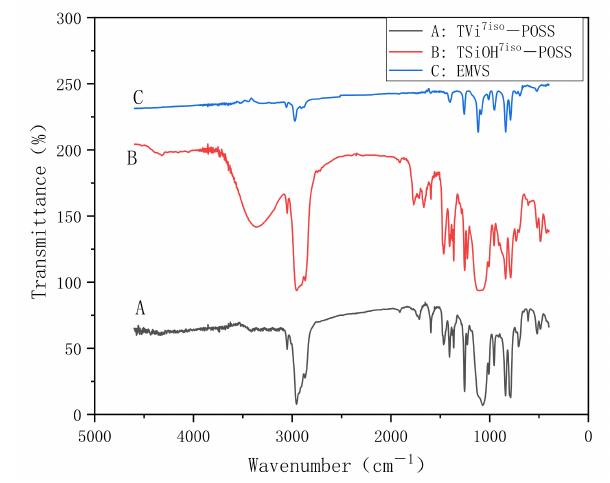
Figure 1. FT-IR spectra of TVi 7iso